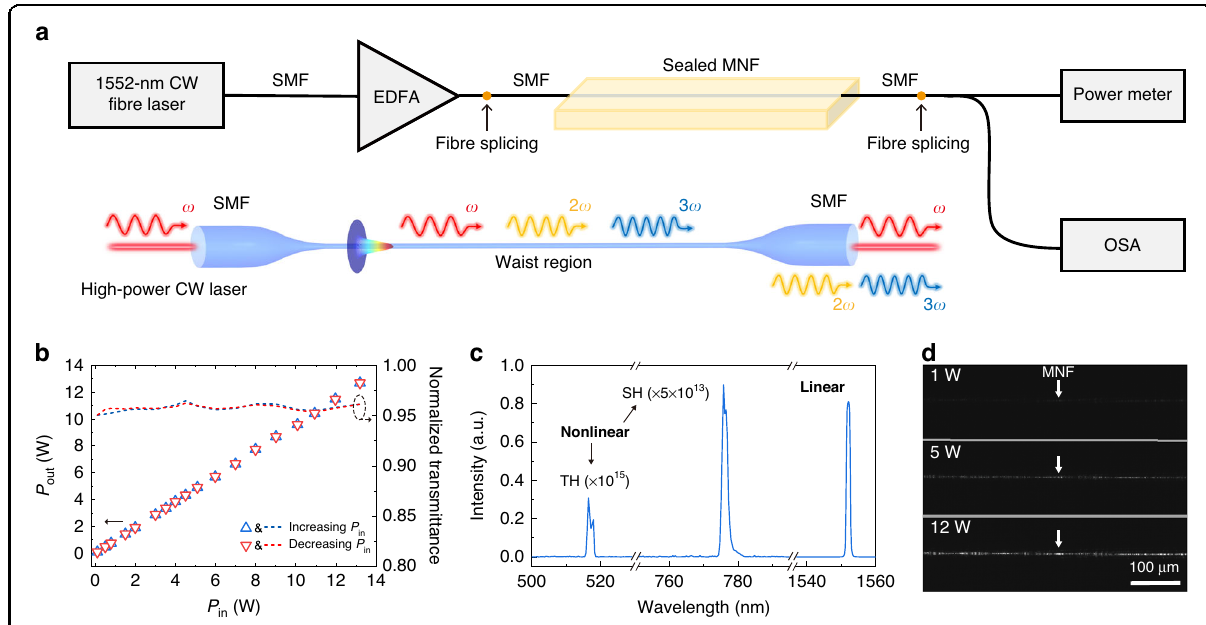
Fig. 1 High-power CW optical waveguiding in MNFs around 1550-nm wavelength. a Schematic diagram of experimental setup and high- power CW optical waveguiding in a MNF. SMF, single-mode fi bre. EDFA, erbium-doped fi bre ampli fi er. OSA, optical spectrum analyzer. b Measured optical transmittance of a 1.1- μ m-diameter, 2-cm-length MNF with a CW waveguided power from 0 to 13 W. c Output spectrum of the MNF with a waveguided power of 12 W. TH, third harmonic, SH, second harmonic. d Optical microscope images showing surface scattering in the same 1.1- μ m- diameter MNF with CW waveguided power of 1 W, 5 W, and 12 W, respectively. The exposure time is 3 ms in capturing all the three